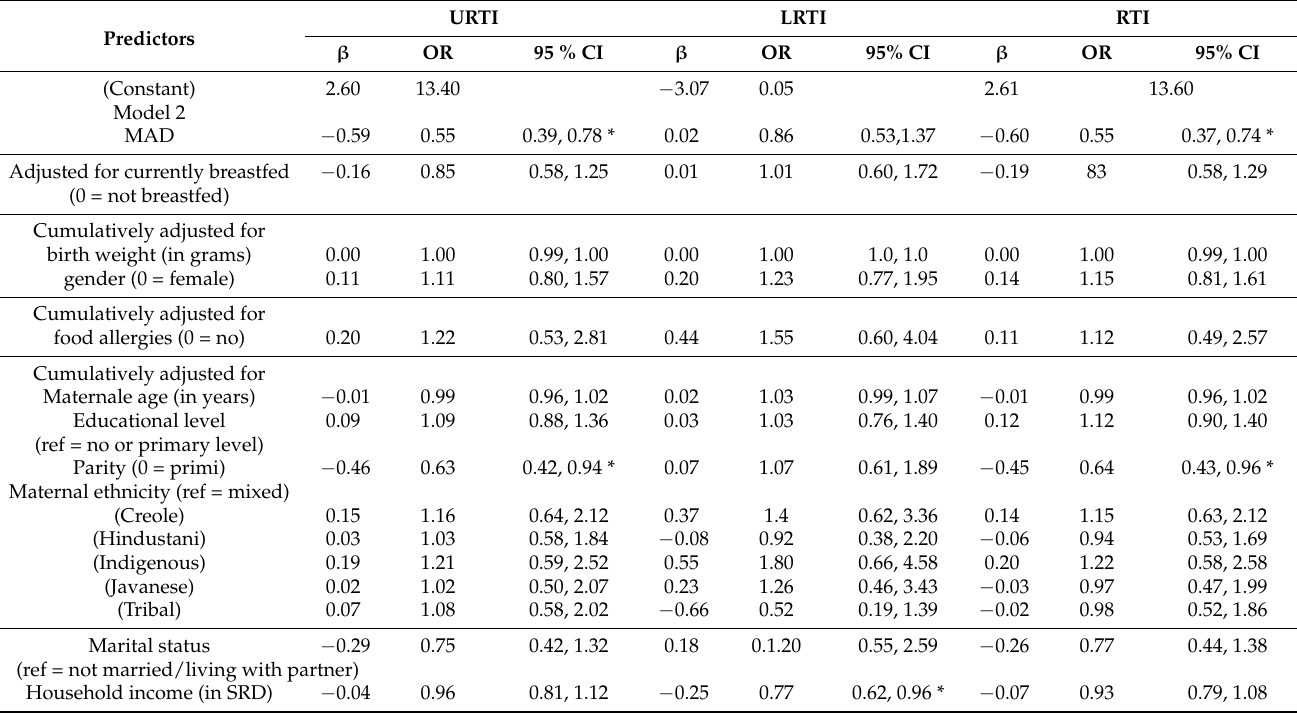
Table 3. Hierarchical logistic regression model 2: Association between the WHO Infant and Young Child feeding (IYCF) indicator minimum acceptable diet (MAD) and respiratory tract infections (RTIs).